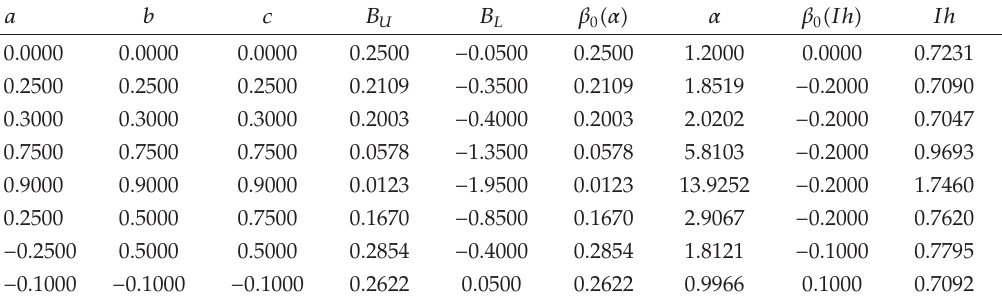
Table 1: Stability results of LMMs (cid:3) 4.3 (cid:4) .